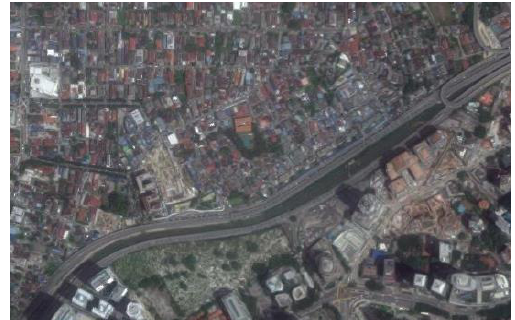
Figure 3. Test Site 2: Kampung Baru (Source: Google Map,